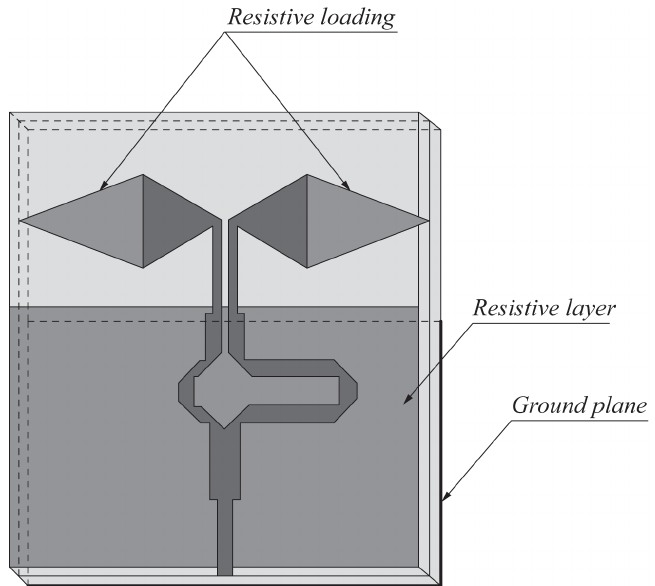
Figure 16. “Dark Eyes” planar antenna for near-field pulsed biological sensing (redrawn from [73]). Dark grey top metal face, medium grey resistive metal face, black bottom metal face, and light grey dielectric